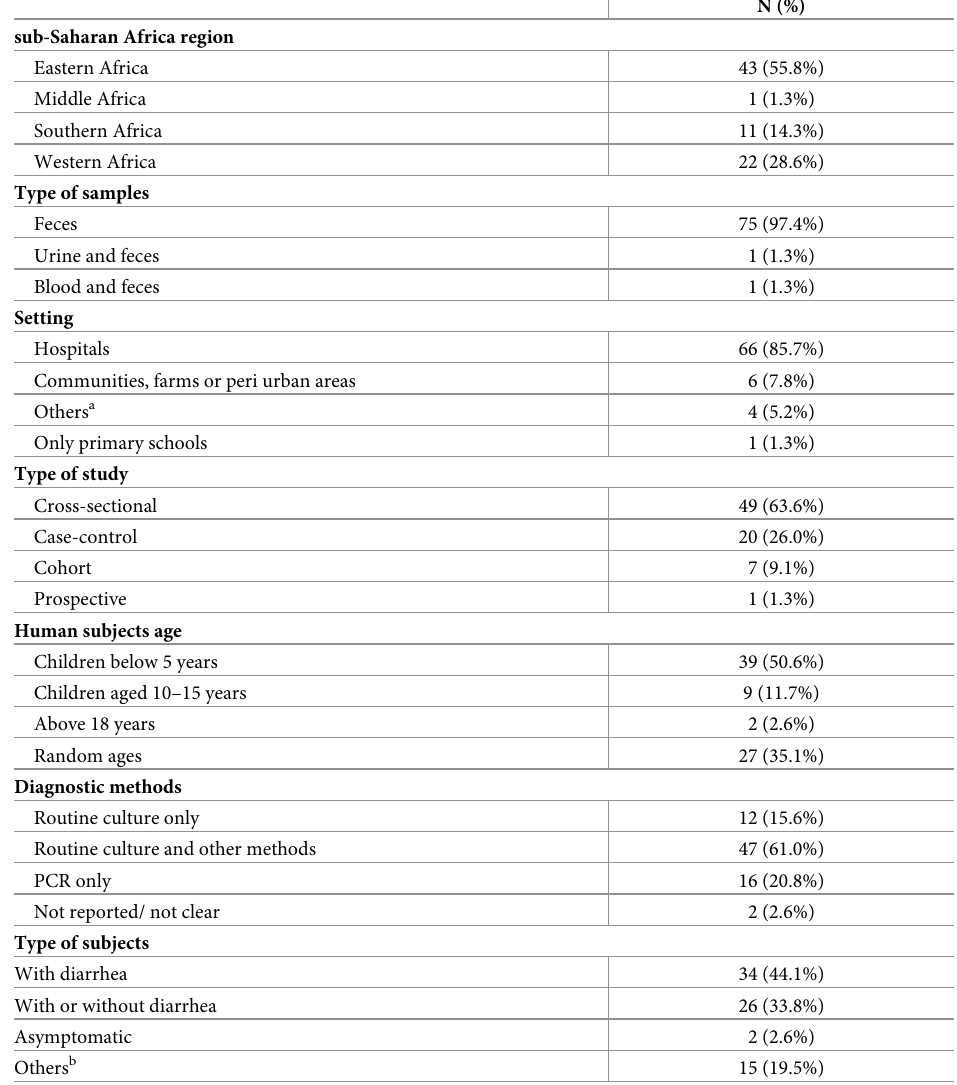
Table 1. Overview of the studies included in the